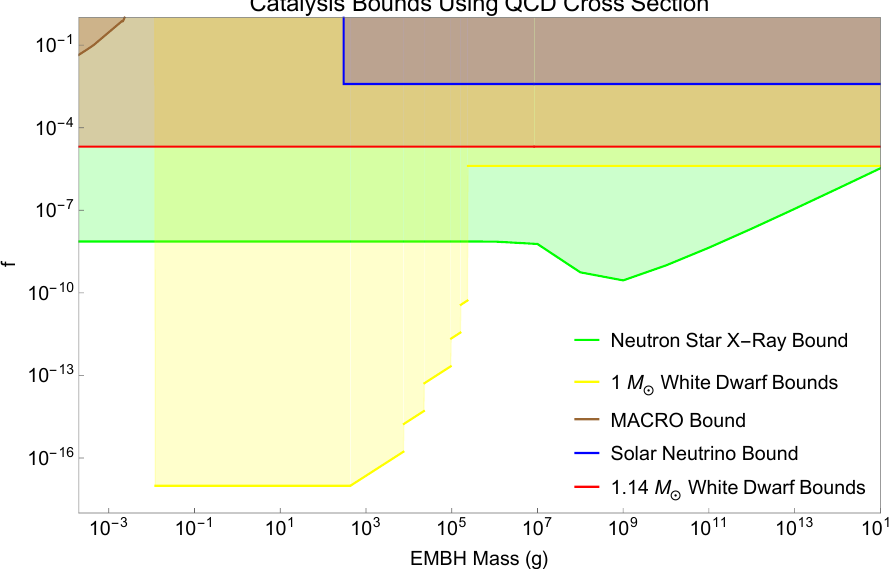
Figure 4 . This plot shows catalysis bounds on EMBH abundance assuming σ cat = σ QCD . The yellow and red lines denote bounds from 1 M (cid:12) WDs and WD J0551+4135 respectively.